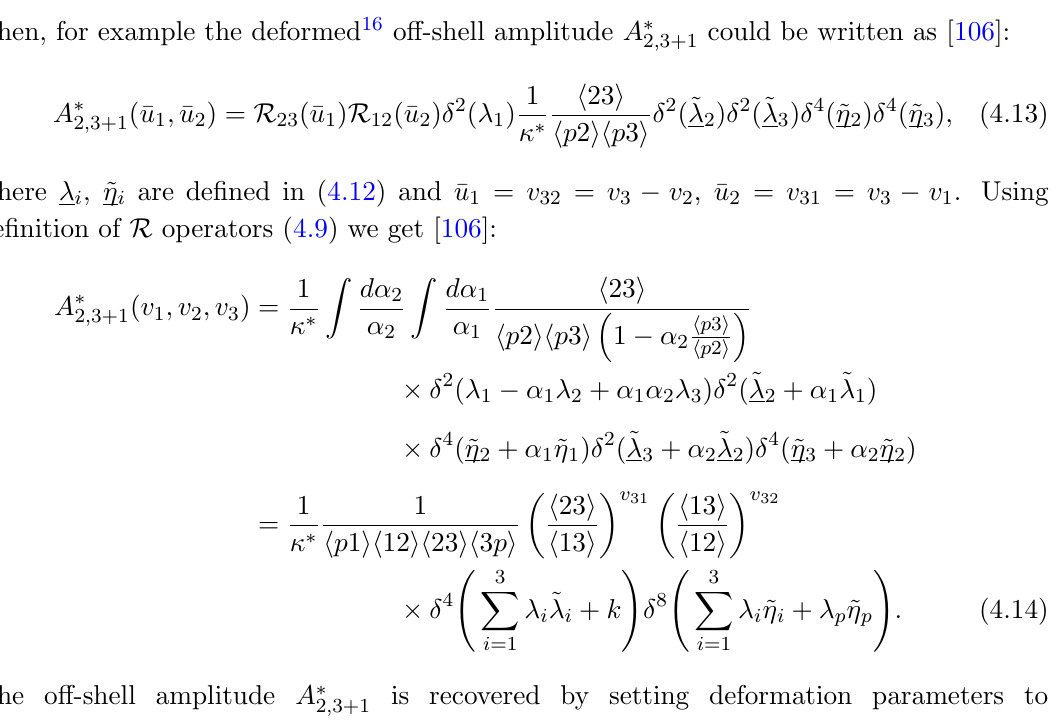
Figure 7 . On-shell diagram construction via BCFW bridges for A (cid:3)